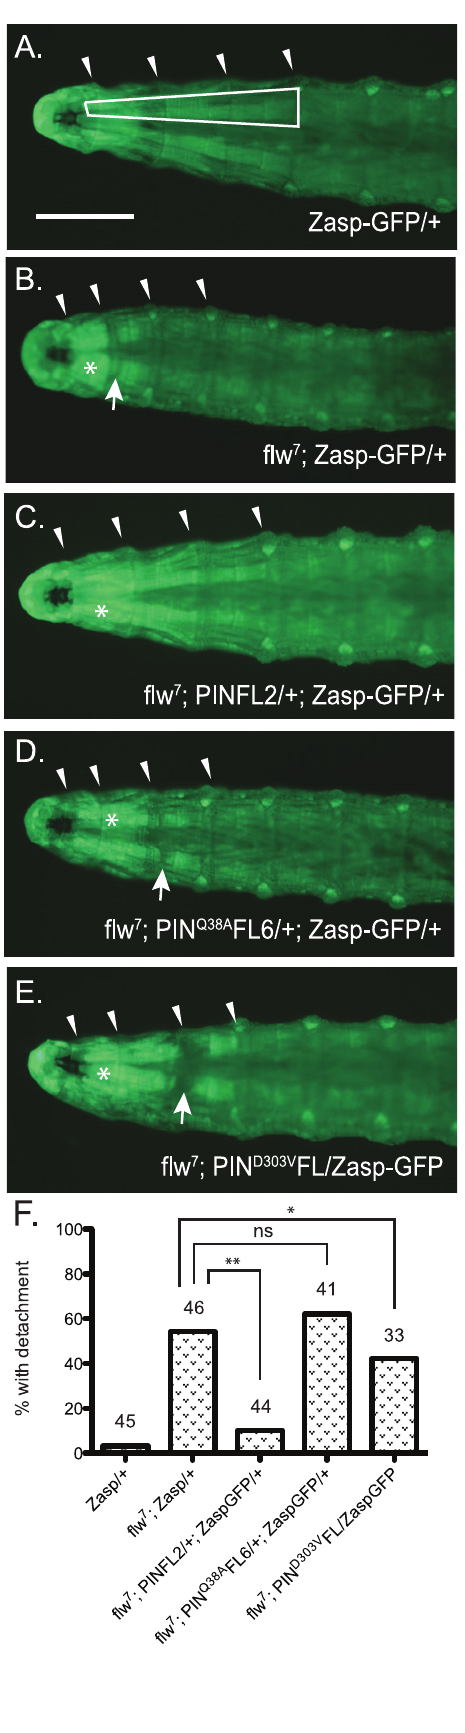
Figure 6. Moderately elevated expression of PINCH rescues muscle detachment defects of the flw 7 mutant. A–E) Represen- tative images of four-day-old larvae of the indicated genotypes are shown. Ventral view allows the VIS muscles to be rapidly scored on a dissecting microscope. One of the medial pair of VIS muscles is boxed in A. White arrowheads show the relevant segment boundaries (T1,T2,T3). Areas of hypercontraction are indicated with an asterisk. Detachments are characterized by a gap in the GFP signal (arrow) Scale bar=1 mm. F) The graph shows the percent of total animals in which the VIS muscles exhibit detachment. Number of animals examined of each genotype, pooled from triplicate experiments, is shown above the bars. ** indicates p , 0.005, * indicates p , 0.05, and ns indicates p .